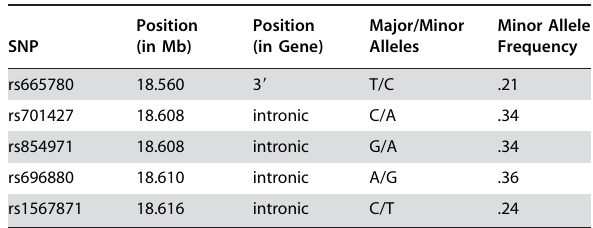
Transmission disequilibrium test (TDT) analysis did not find evidence for unequal allelic transmission ratios at any of the tested variants in the combined sample (data not shown). Application of the more powerful linkage and association modeling in pedigrees Table 1. Position and minor allele frequency of SNPs .. ... .... ... ... .... ... ... .... ... ... .... ... ... .... ... ... .... ... ... ....